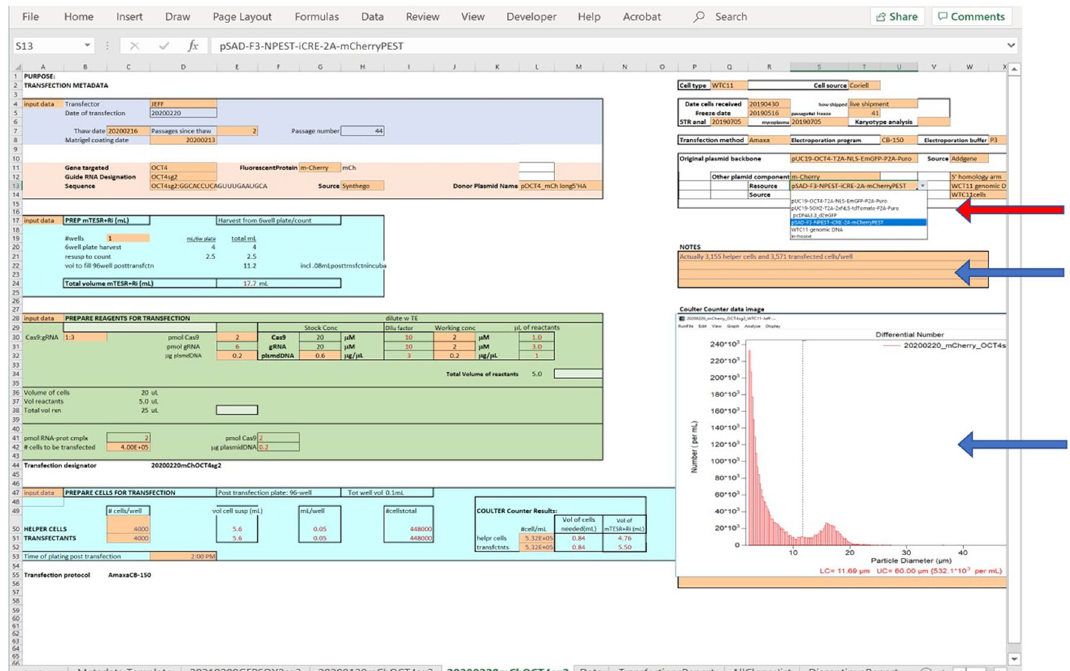
Figure 5. The Transfection Metadata Template worksheet. This is a partial view of the worksheet showing a drop-down menu, indicated by the red arrow, of plasmid component sequences to choose from, and the areas of the worksheet that provide space for free text and for insertion of an image (e.g. of data from a cell counter), indicated by the blue arrows. The green box contains automated calculations of amounts and volumes of materials to use in the transfection in response to user inputs. Limits are imposed on some of the values to conform with experimental protocol. Cells colored in orange are cells where the user inputs data by choosing from a drop-down list or by entering values or free text.